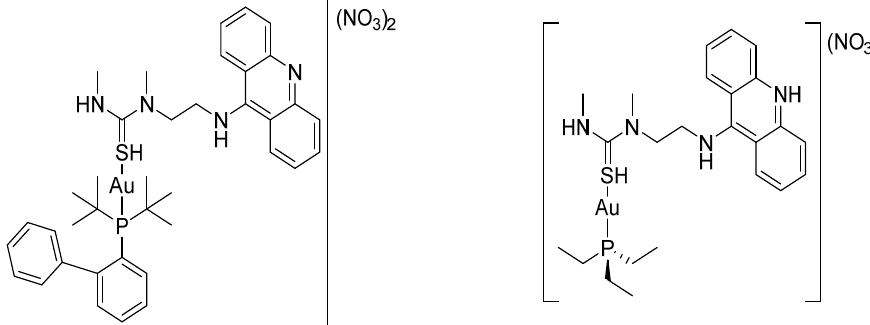
Figure 12. The chemical structures for a selection of AF derivatives containing the S ‐ coordinating (1 ‐ [2 ‐ (acridin ‐ 9 ‐ ylamino)ethyl] ‐ 1,3 ‐ dimethylthiourea) (ACRAMTU) ligand and the 1,1 ′‐ biphenyl ‐ 2 ‐ yl]di ‐ tert butylphosphine) (JohnPhos) ( a ) and triethylphosphine ( b ) [106].